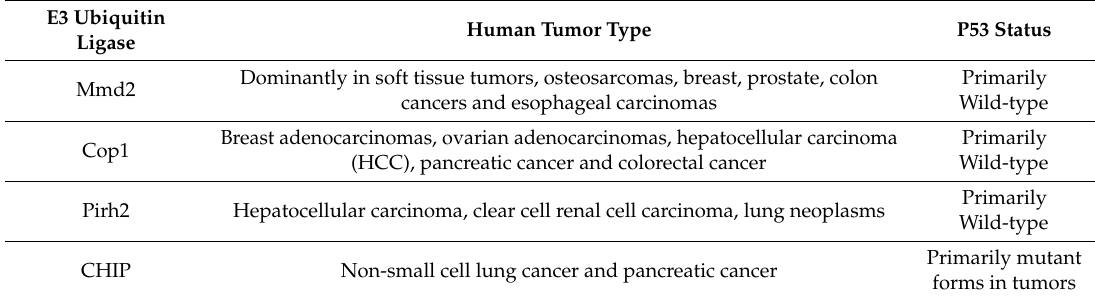
Table 2. This table summarizes the four major E3 ubiquitin ligases and the status of p53 (wild-type and mutant forms) discussed in this review. See the main text for details and related references. Understanding the correlations between these E3 ubiquitin ligases and the tumor suppressor functions of p53 in different types of tumors will have prognostic and therapeutic implications for a new generation of anti-cancer drugs.